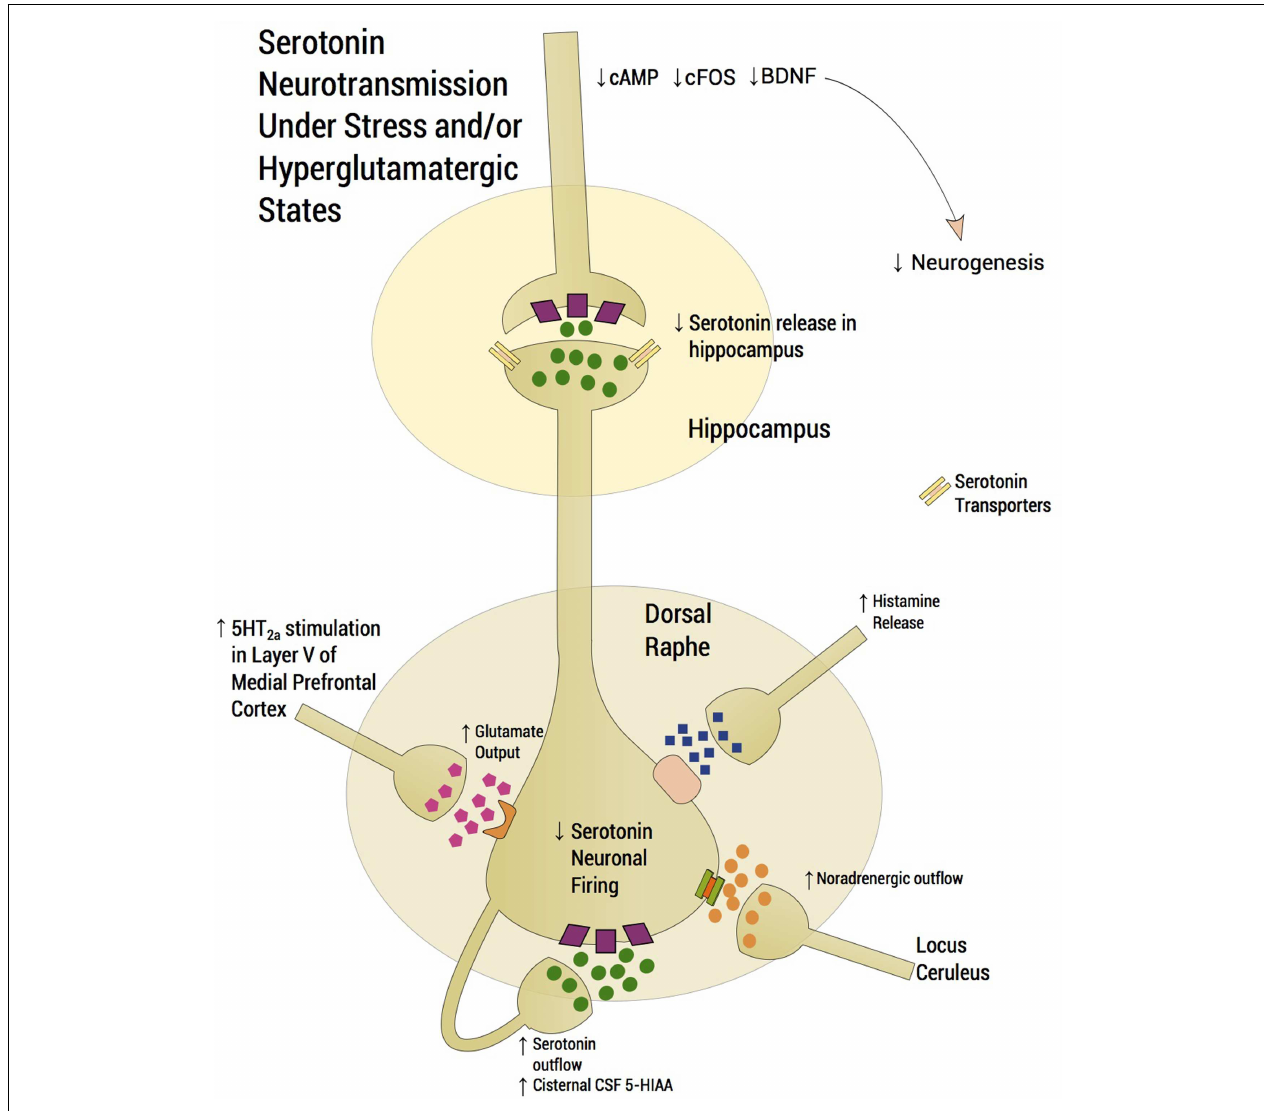
cisternal CSF taps in adversely reared non-human primates where elevations of CSF 5-HIA have been noted in adversely reared subjects in comparison to normally reared controls. Glutamate, serotonin, noradrenaline, and histamine are activated by stress and exert an inhibitory effect on serotonin outflow, in part, by “flooding” 5-HT 1A autoreceptors by serotonin itself. Factors, which may exacerbate this scenario, such as presence of the short arm of the serotonin transporter gene, early life adversity and comorbid bipolar disorder, are generally associated with SSRI-treatment resistance. An excess of midbrain peri-raphe serotonin is associated with a subsequent deficit at important fronto-limbic projection sites, with a compromise in serotonin-mediated